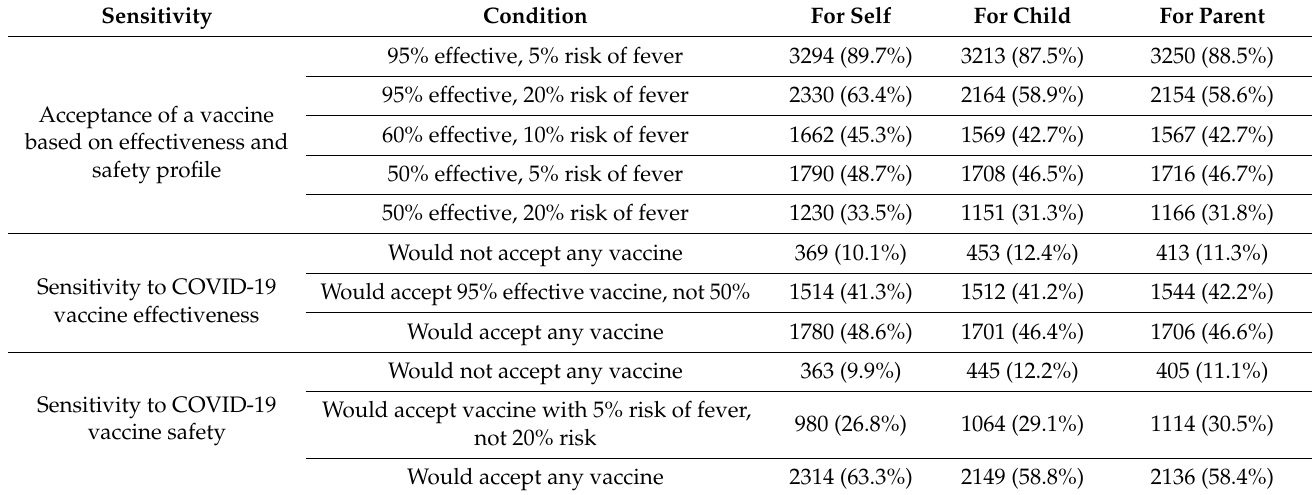
Table 2. Acceptance of a COVID-19 vaccine, based on the safety and effectiveness profile. Sensitivity